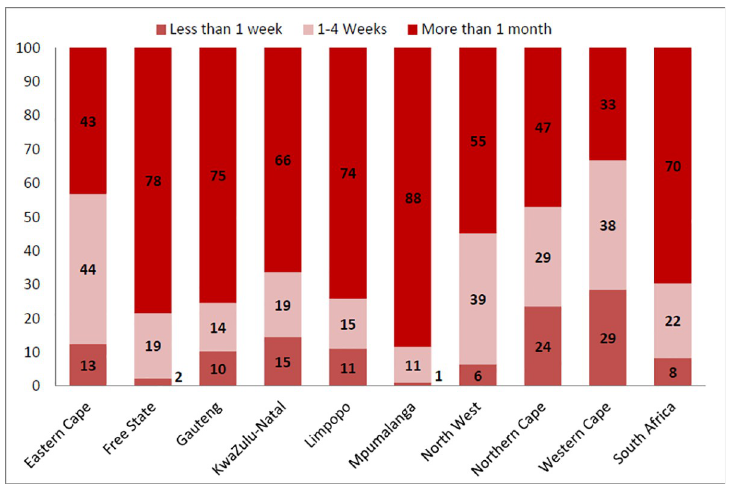
Fig 6. Percentage of resolved stock-outs lasting (i) less than 1 week, (ii) 1–4 weeks, and (iii) more than 1 month by type of province.